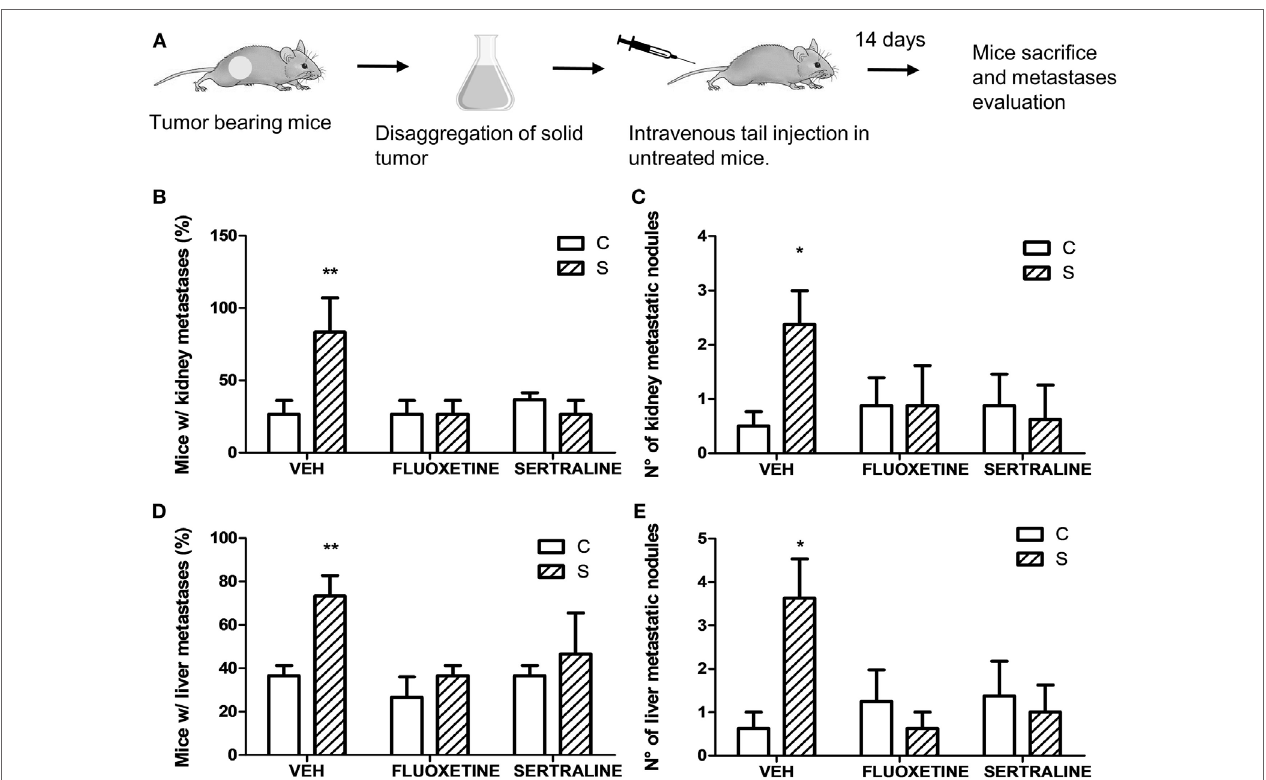
FigUre 4 | Experimental metastasis assay using cells from solid tumors of different experimental groups. 14 days post subcutaneous injection of EL4 cells in mice from different experimental groups, solid tumors were excised and disaggregated. 5 × 10 5 cells were injected intravenously in untreated mice. Two weeks later, mice were sacrificed. (a) Schematic representation of experimental protocol. Percentage of mice with metastatic nodules in kidney (B) or liver (D) was calculated. Number of metastatic nodules in kidney (c) or liver (e) was assessed. Results are the mean ± SEM of two independent experiments ( n = 5 and 4 mice per group). * p < 0.05, ** p < 0.01 respect to control